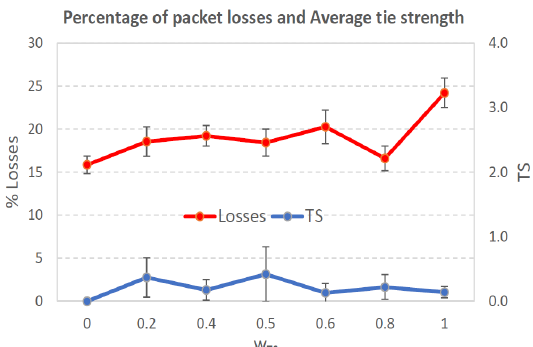
Figure 6. Percentage of packet losses and average tie strength of the forwarding path. Scenario with very low social media interaction (TS normal distribution with µ = 1 and σ = 1). Nodes’ density = 200 nodes/km 2 .